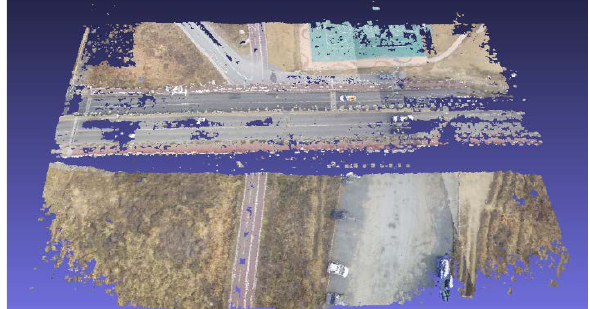
Figure 12. Point cloud generated over entire ROI with RGB